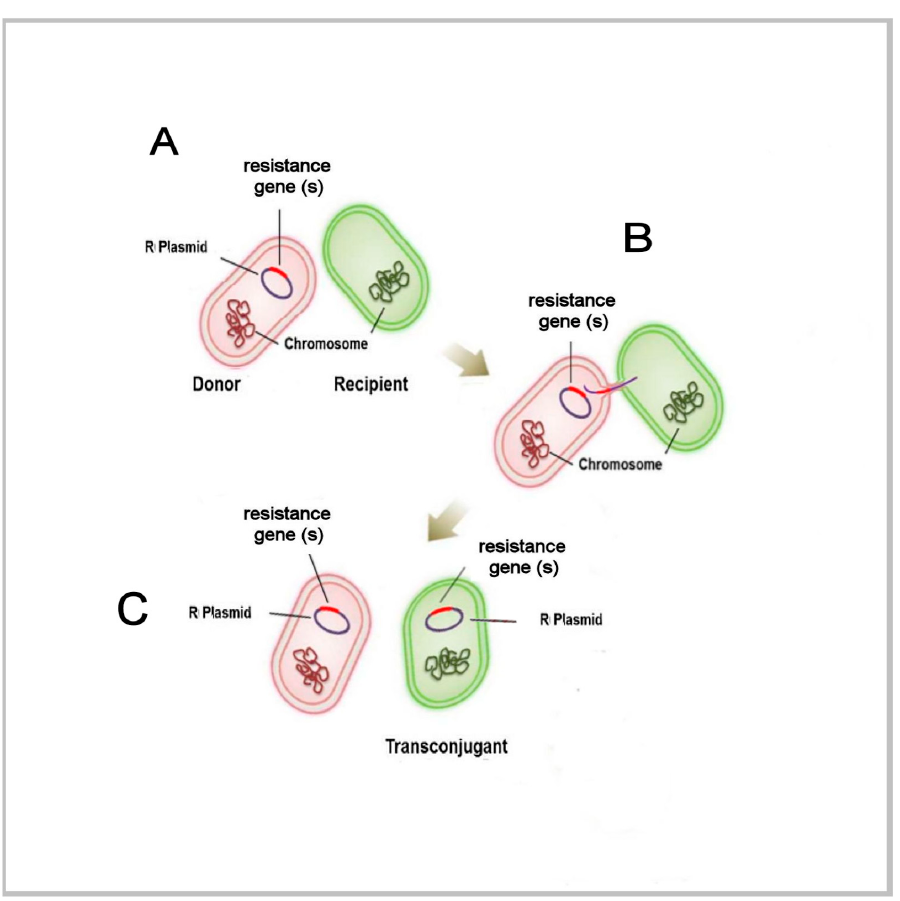
Figure 1. Antibiotic-resistant plasmid conjugative transfer in prokaryotes. ( A ) In biofilms, via complex cell–cell commu- nication mechanisms believed to be activated through quorum sensing, potential donor and recipient cells identify one